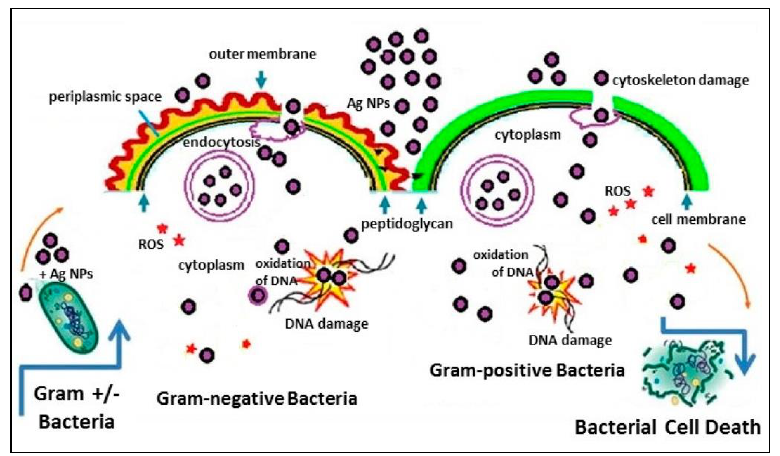
Figure 3. Schematic diagram of bactericidal activity of AgNPs on Gram-positive and Gram-negative bacteria. Reprinted from [105], an open access article distributed under the Creative Commons Attribution License. ROS: reactive oxygen